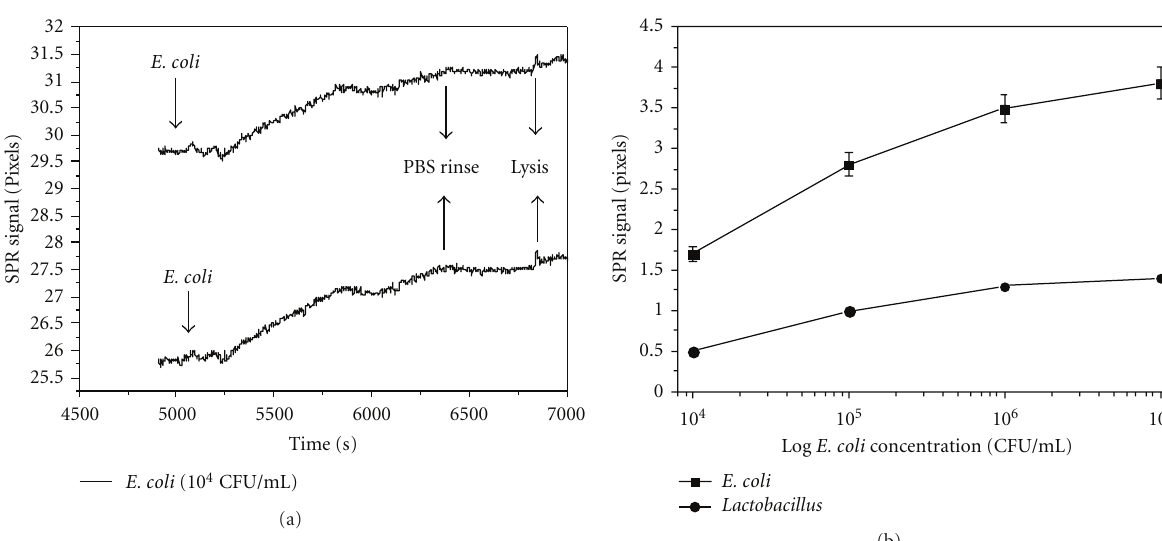
Figure 4: (a) SPRi signal over time after bacteria injection (10 4 CFU/mL of E. coli ). (b) Calibration curve of SPRi signal versus E. coli concentrations (squares) and versus Lactobacillus bacteria